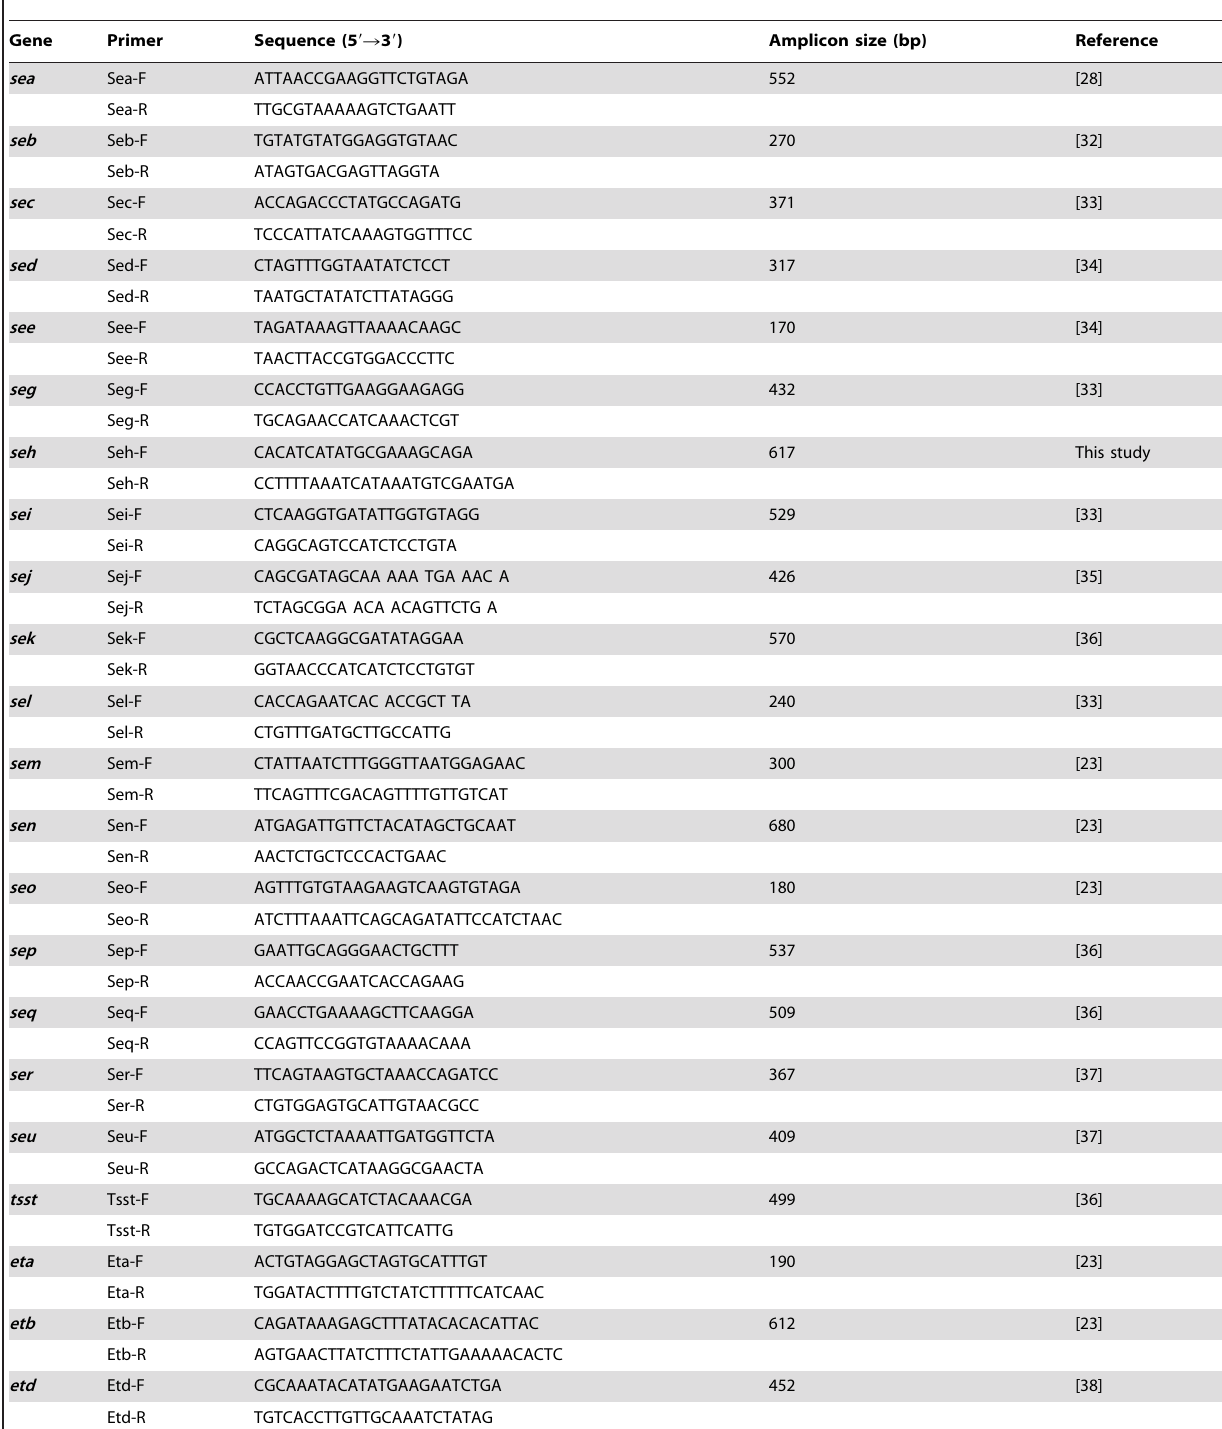
Table 4. Primers used for PCR amplification of toxin genes in S. aureus